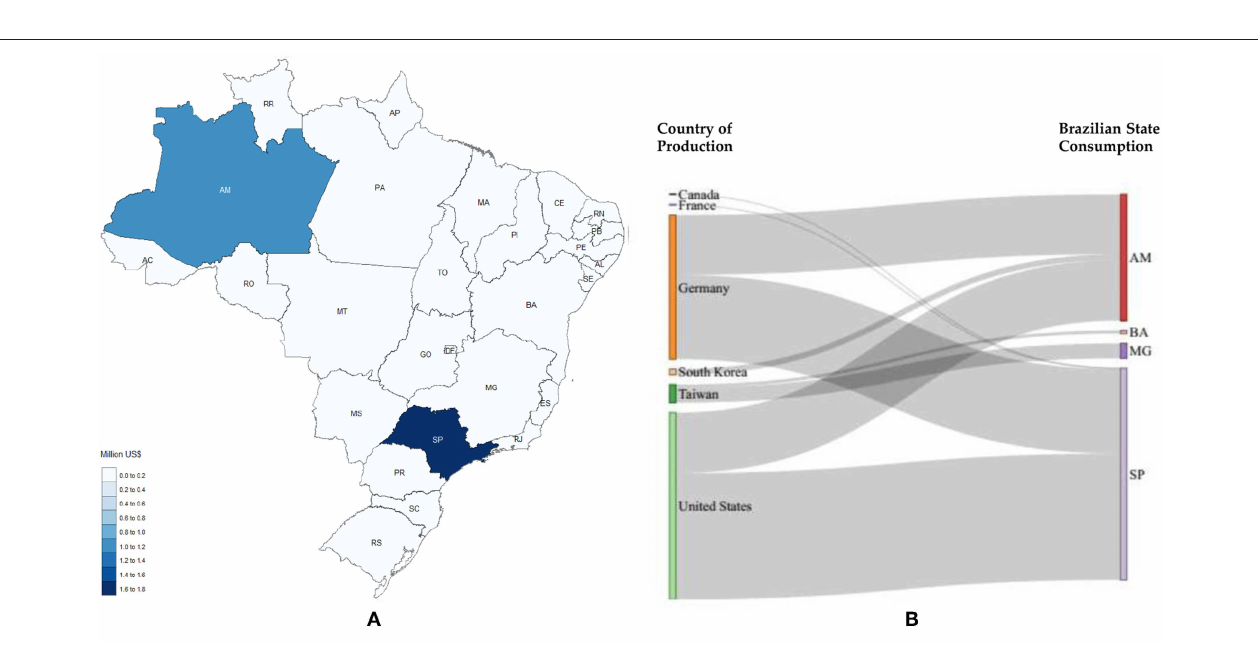
FIGURE 9 | Polycarbonate imports. (A) Local needs considering 2017; (B) Stratification for 2017, countries on the left represent the origin of the product studied and the states on the right represent the destination (AM, Amazonas; BA, Bahia; MG, Minas Gerais; SP, São Paulo).